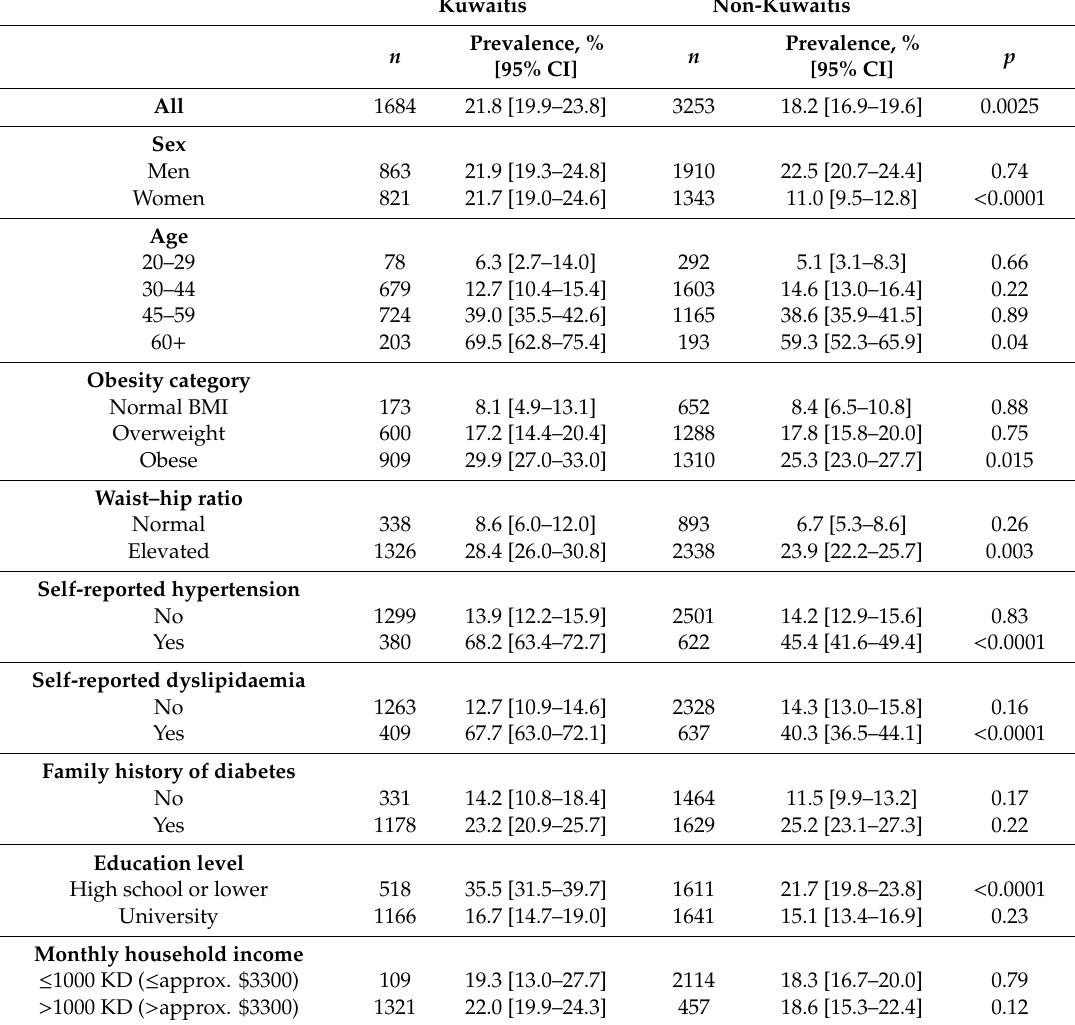
Table 3. Adjusted prevalence of diabetes by nationality in adults aged 20 years or